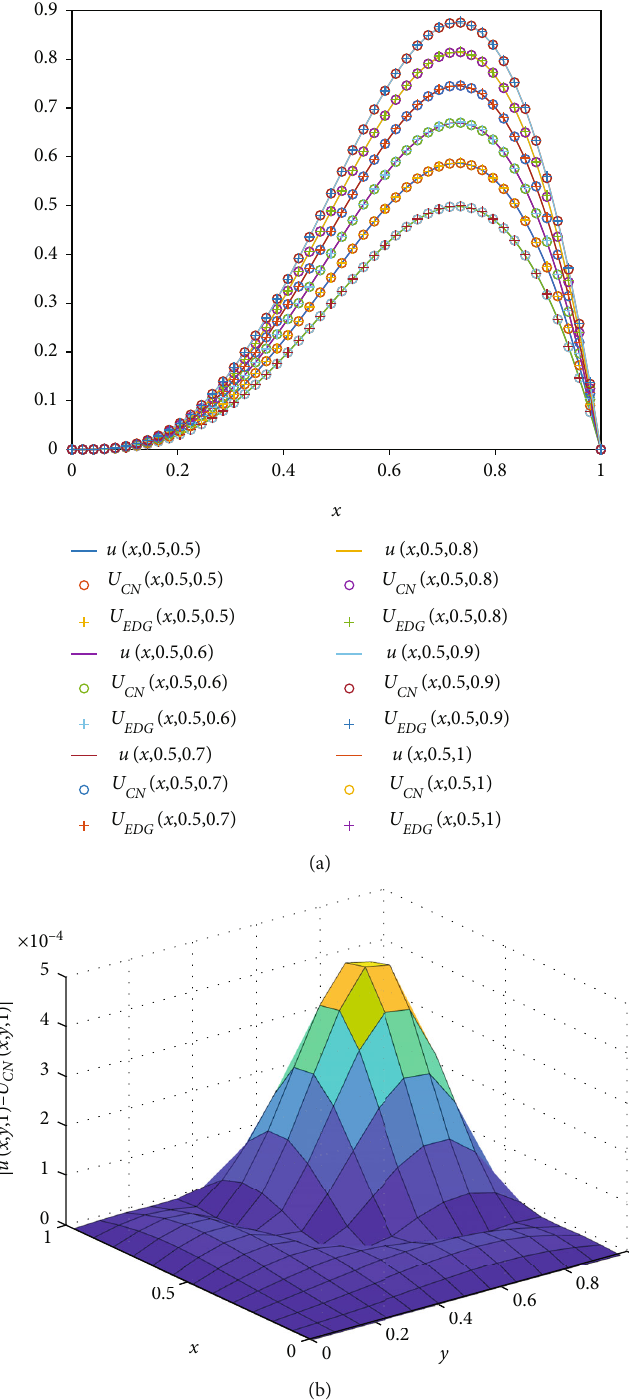
Figure 4: The exact, Crank – Nicolson and EDG solutions in di ff erent values of t and y = 0 : 5 (a) and the absolute error of Crank – Nicolson method at T = 1 (b) of Example 14 for Δ t = 0 : 01 , Re = 50 , N = 49 , and α = 0 : 5